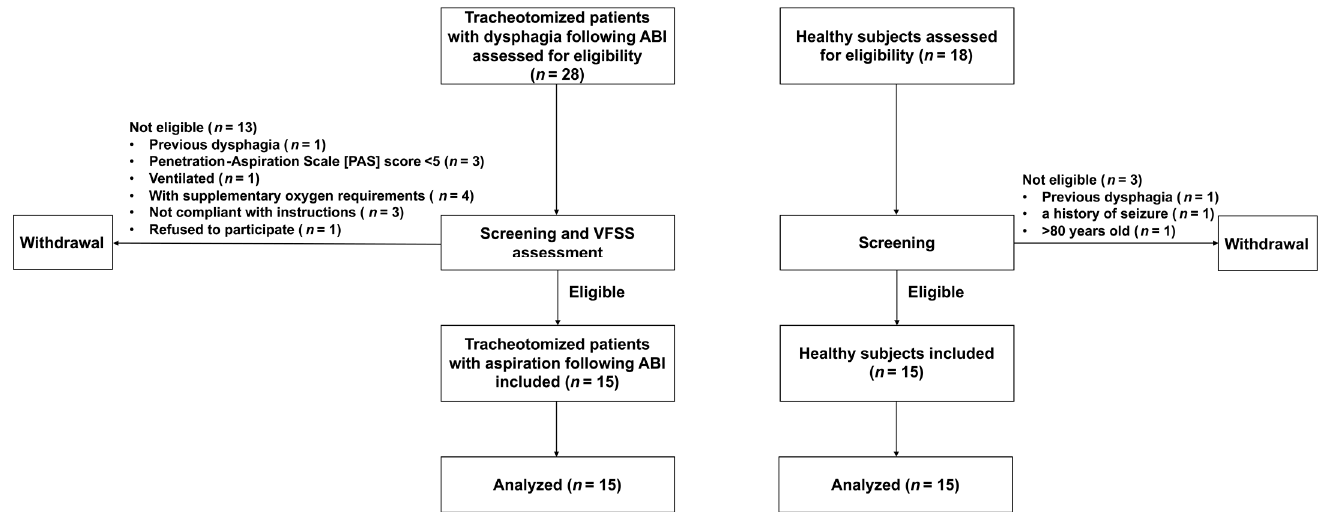
Figure 1. Participants’ flow diagram. Table 1. Clinical characteristics in the patient and control groups.